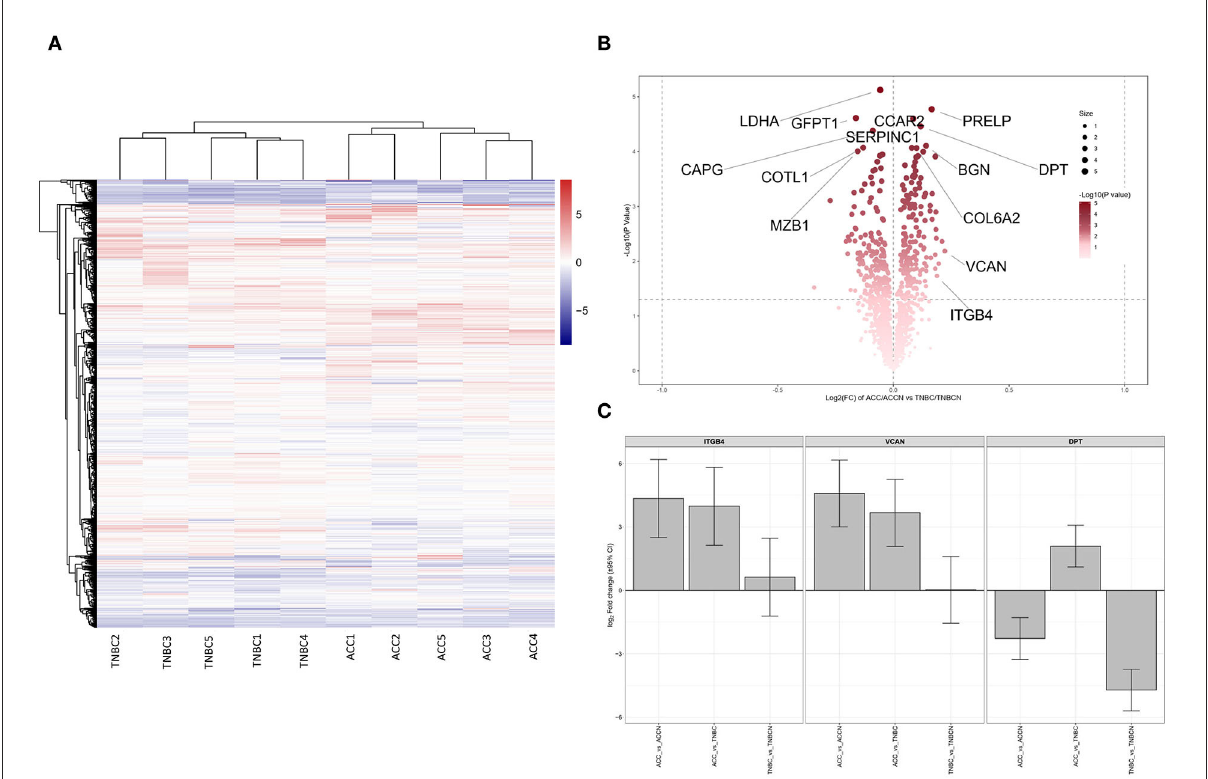
FIGURE3 (A) Heat map of all DEPs ratio of (ACC/ACCN) and (TNBC/TNBCN). (B) Volcano plots of all DEPs ratio of (ACC/ACCN) and (TNBC/TNBCN). Some of the significant DEPs are labeled. (C) The expression difference of ITGB4, VCAN, and DPT between ACC and TNBC after normalization by the expression ratio of (ACC/ACCN) and (TNBC/TNBCN). ACCN, the adjacent normal breast tissue of ACC; TNBCN, the adjacent normal breast tissue of